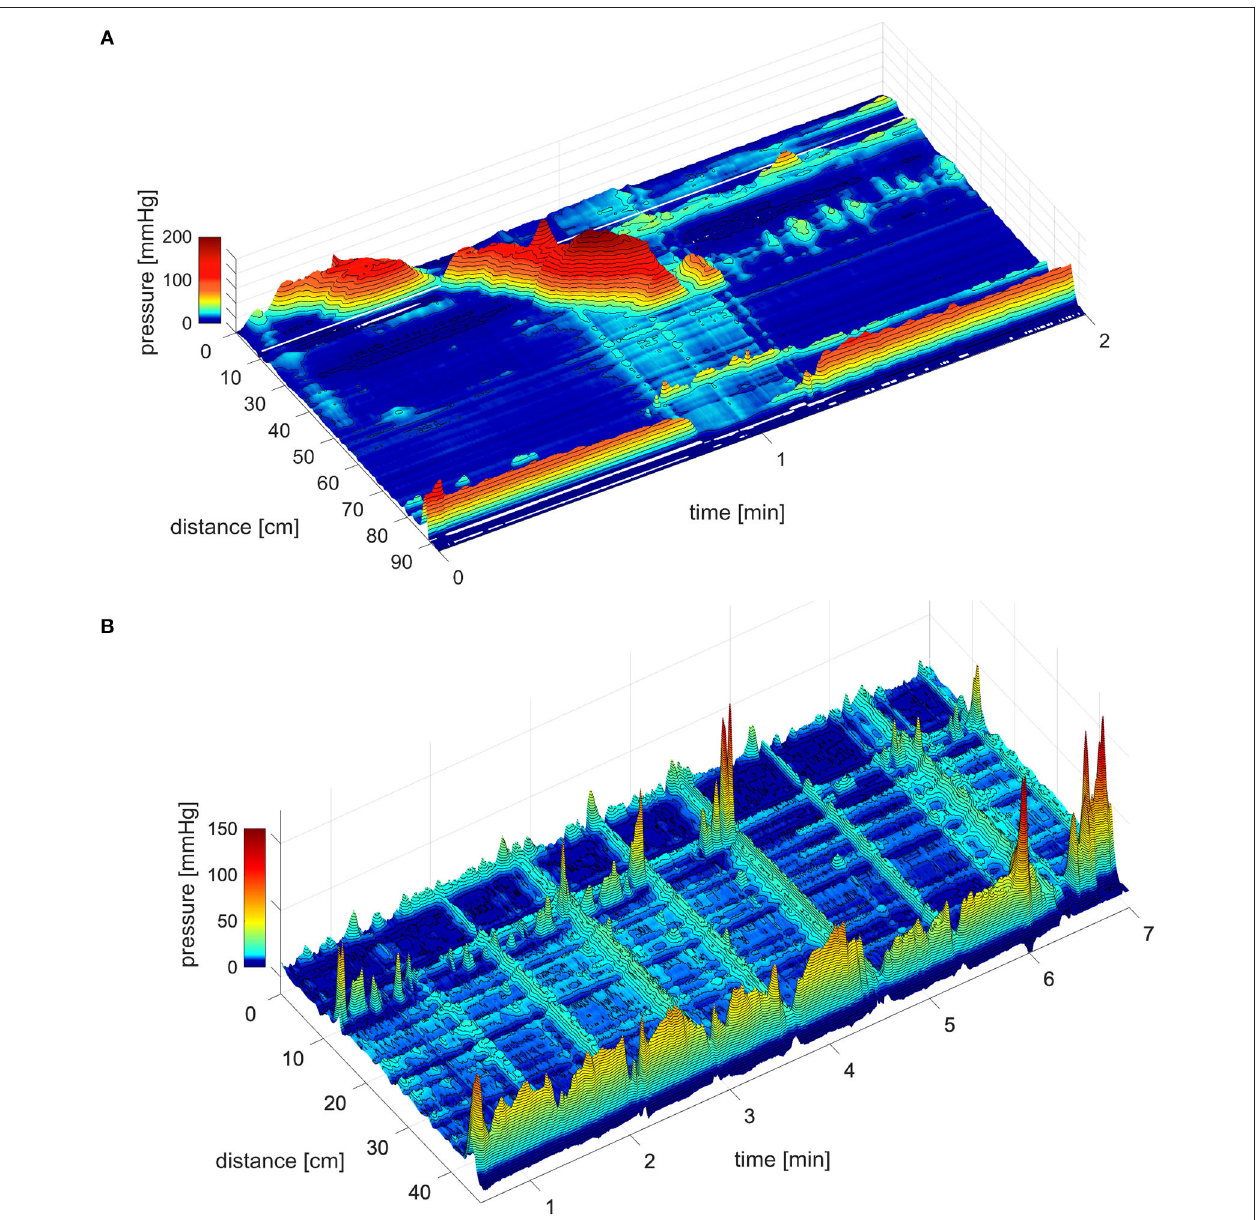
FIGURE 1 | The coloanal reflex. (A) The coloanal reflex associated with an HAPW followed by a simultaneous pressure wave that enters the rectum followed by complete relaxation of the anal sphincters. 0cm is in the proximal colon, the anal sphincter is at 85cm. The white line represents a 10cm section where a balloon